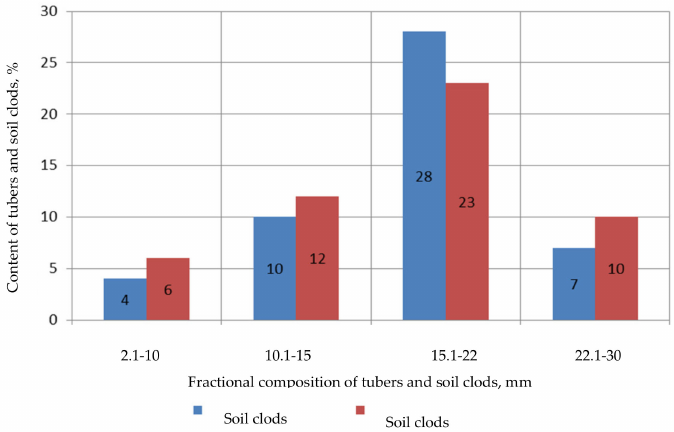
Figure 2. Fractional composition of the tuberous heap in the hopper of a potato